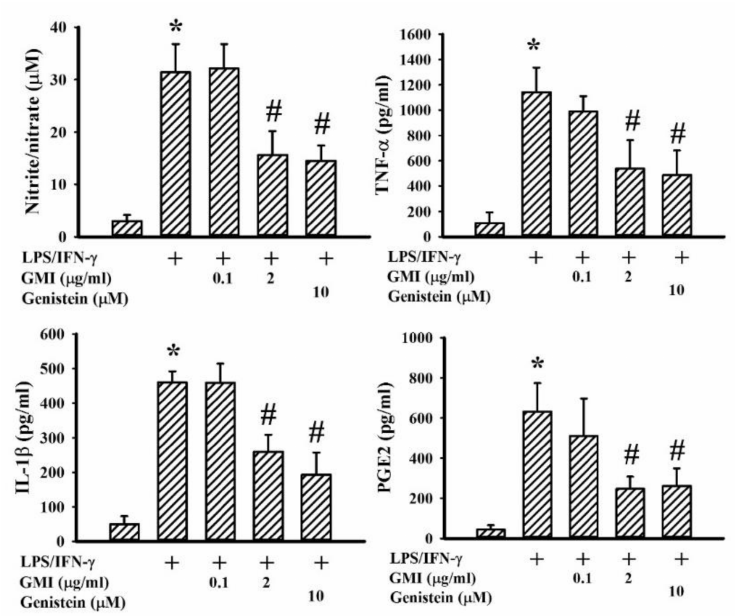
Figure 3. GMI alleviated inflammatory mediator production in neuron/glia cultures. Neuron/glia cultures were pretreated with vehicle, various concentrations of GMI (0.1 and 2 µ g/mL), or genistein (10 µ M) for 30 min before being incubated with LPS (100 ng/mL)/IFN- γ (10 U/mL) for an additional 24 h. Supernatants were collected and subjected to Griess reagent or ELISA for the measurement of NO, TNF- α , IL-1 β , and PGE2. * p < 0.05 vs. untreated control and # p < 0.05 vs. LPS/IFN- γ control, n = 4. The + means the groups treated with LPS/IFN- γ and the rest groups without + indicate vehicle treatment.